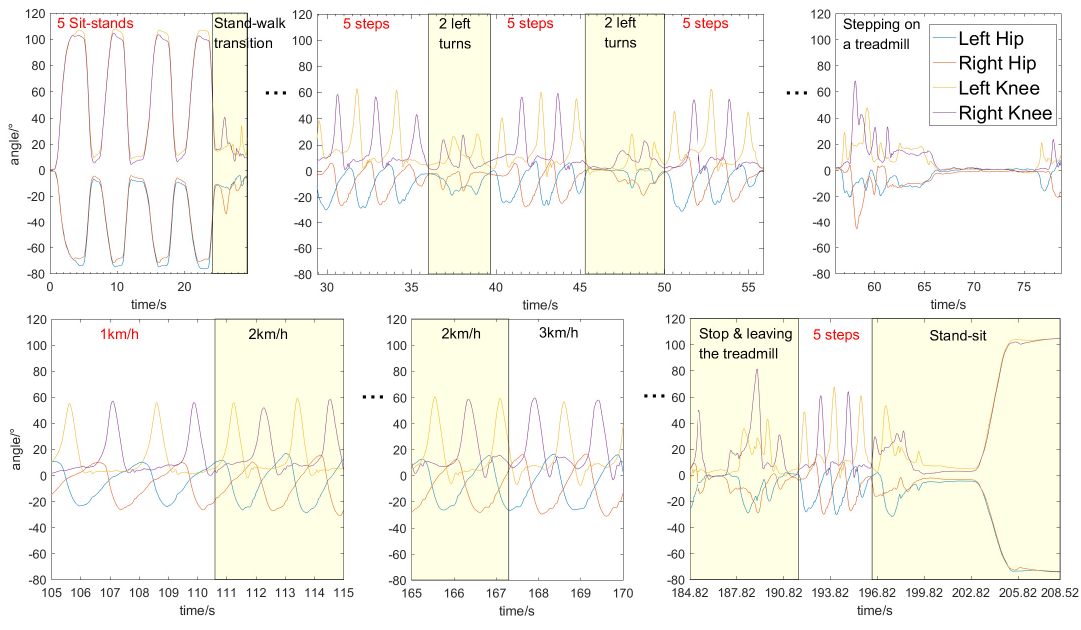
Figure 7. Dataset for prediction method assessment (the joint angles of the knees and hips of a test subject in a sagittal plane collected by the inertial measurement unit-based motion capture